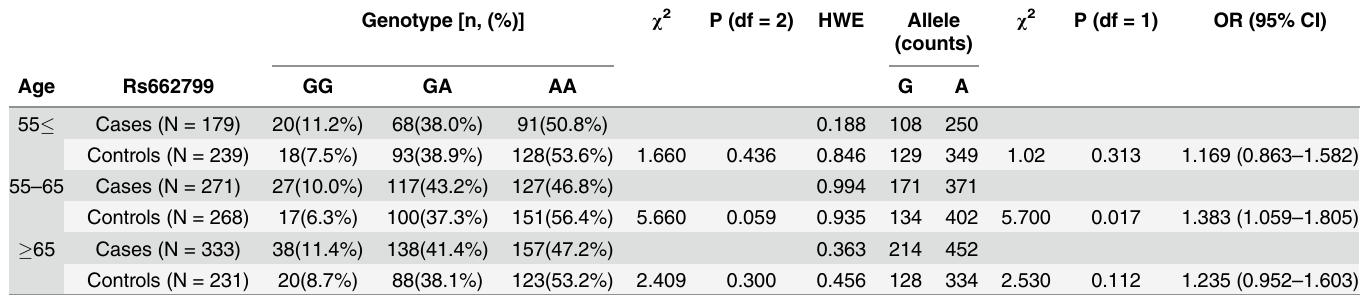
Table 2. Genotype and allele frequencies in cases and controls with different age